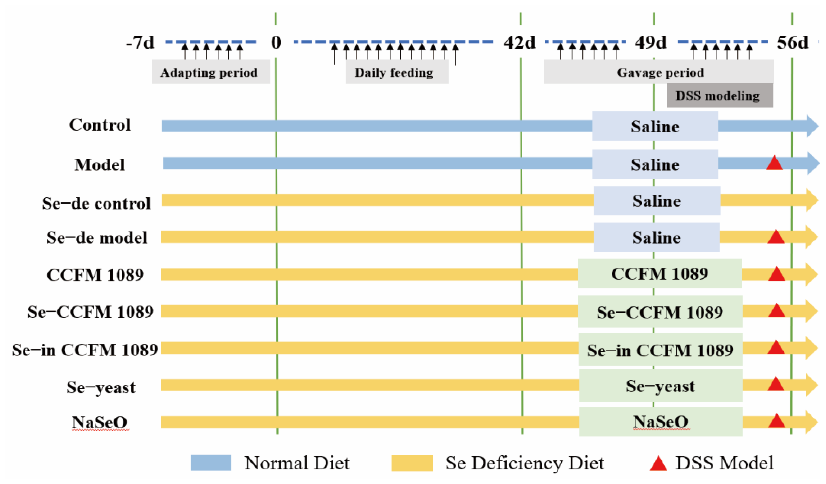
Figure 1. Progress of the animal experiment. During the experimental period, the body weight, food intake, stool consistency and presence of blood in the stool of the mice were recorded daily , occult blood was measured using Occult Blood Test Kit [25] (Zhuhai Beisuo Biotechnology Co. Ltd., Zhuhai, China), and the health and behavior of the mice was observed regularly. At the end of the exper- iment, mice were narcotized and sacrificed. The blood of the mice was centrifuged , and the serum was stored at − 80 °C until further analysis. The liver, colon, and ileum tissues were also collected and stored at − 80 °C until further use.